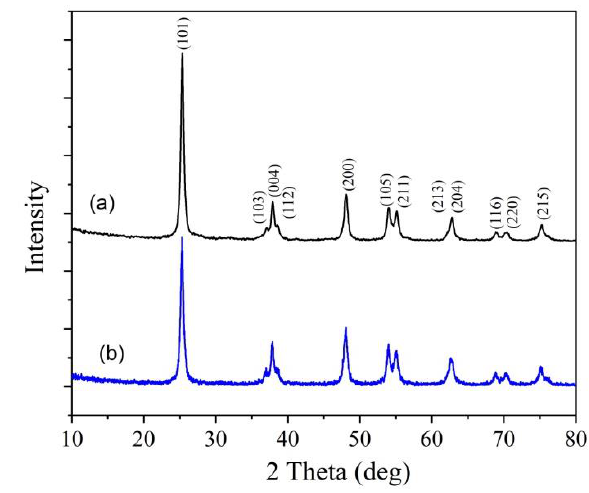
Figure 2. XRD patterns of TiO 2 nanoparticles before ( a ) and after ( b ) photocatalysis.